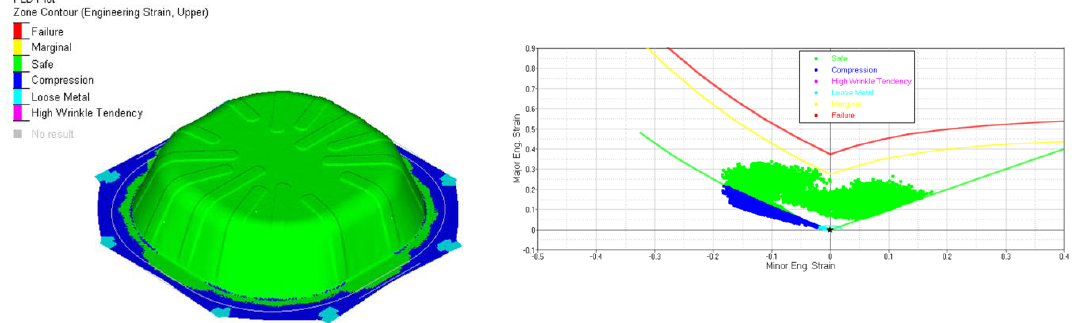
Figure 3. Forming limit diagram (FLD) for RUN0.